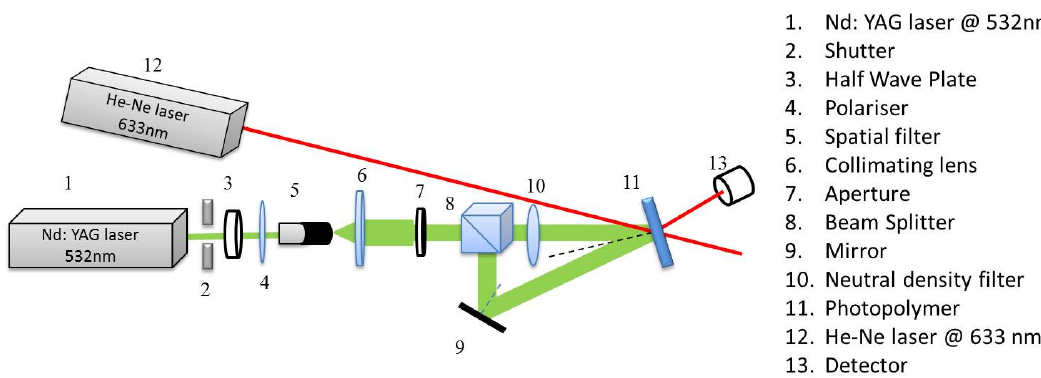
Figure 3. Experimental set-up for recording of the SRG